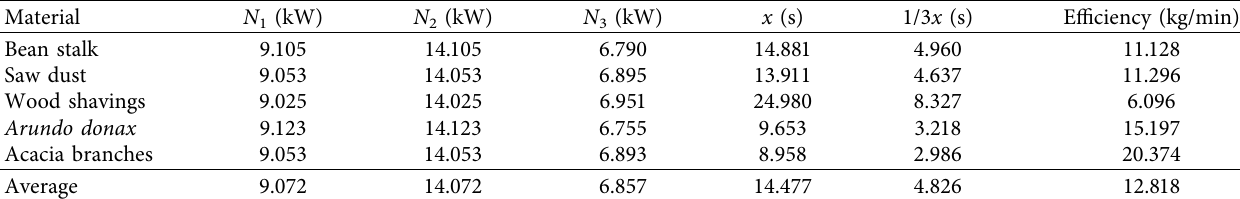
Table 2: Calculation